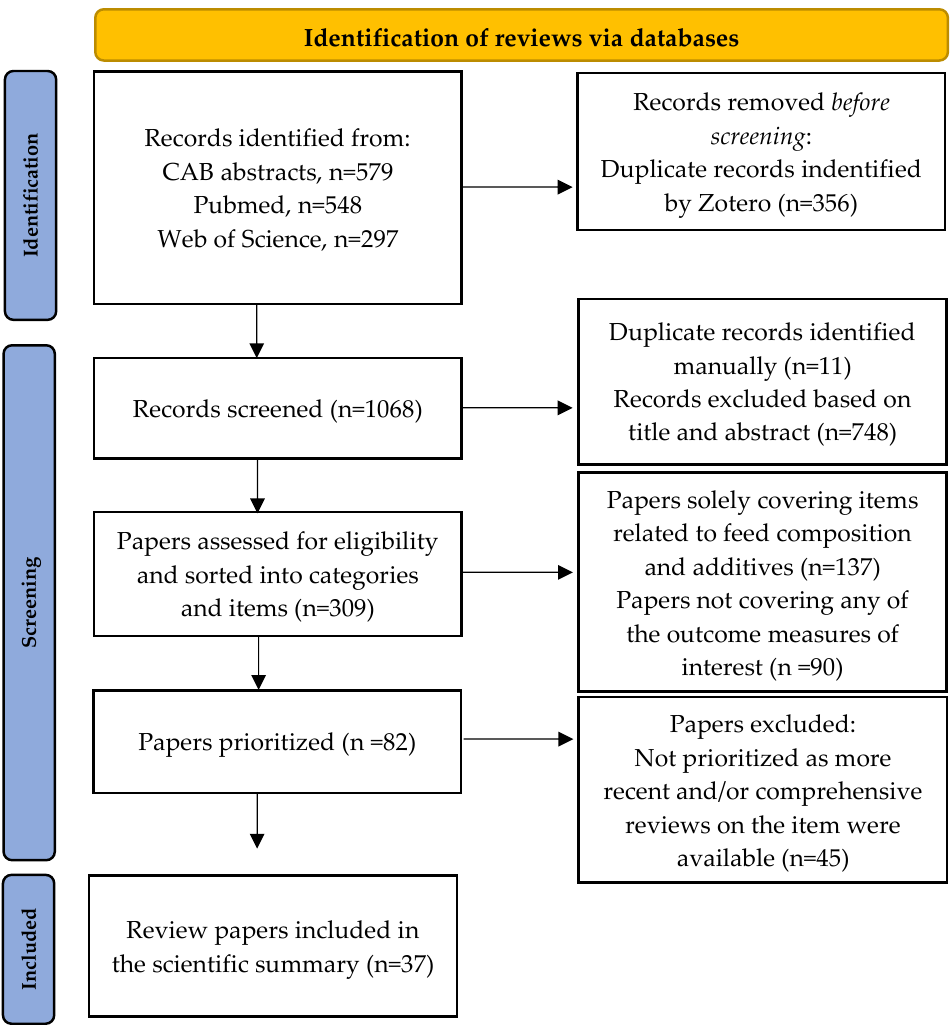
Figure 2. Flow chart of the searching, sorting and inclusion of review papers for the scientific summary. Modified from [22]: Page MJ, McKenzie JE, Bossuyt PM, Boutron I, Hoffmann TC,